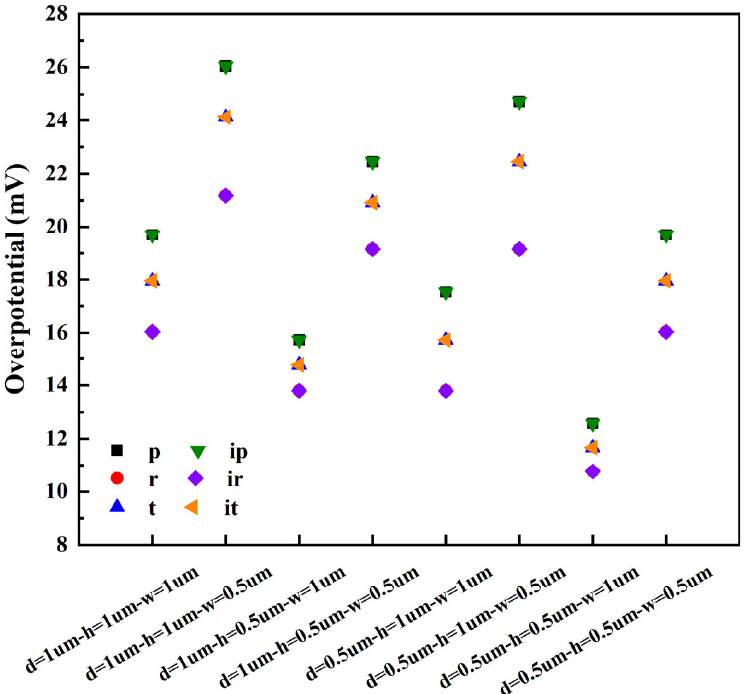
Figure 7. The overpotentials of micro-nano surface electrodes with different structure types and graphic parameters under the same current density of 10 mA cm − 2 .